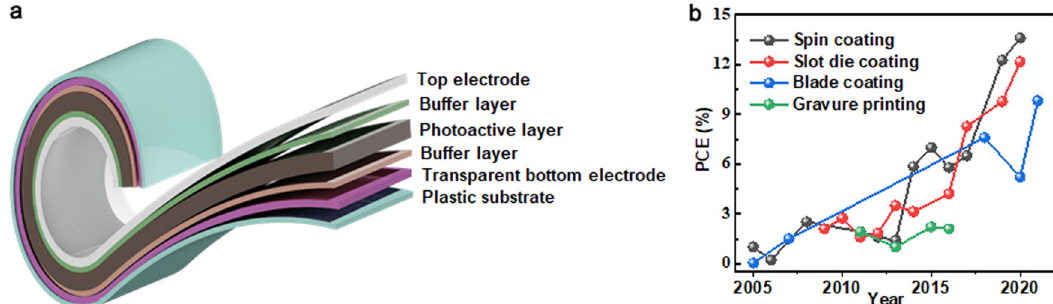
Fig. 1 The development of large-area organic solar cells. a Typical device structure of fl exible OSCs. b Ef fi ciency progress of fl exible large- area ( ≥ 1 cm 2 ) OSCs prepared by different coating